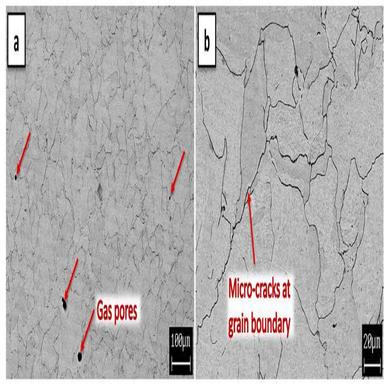
SEM image of Mo electrolytically etched sample displaying (a) gas pores and (b) micro-cracks at grain boundaries.